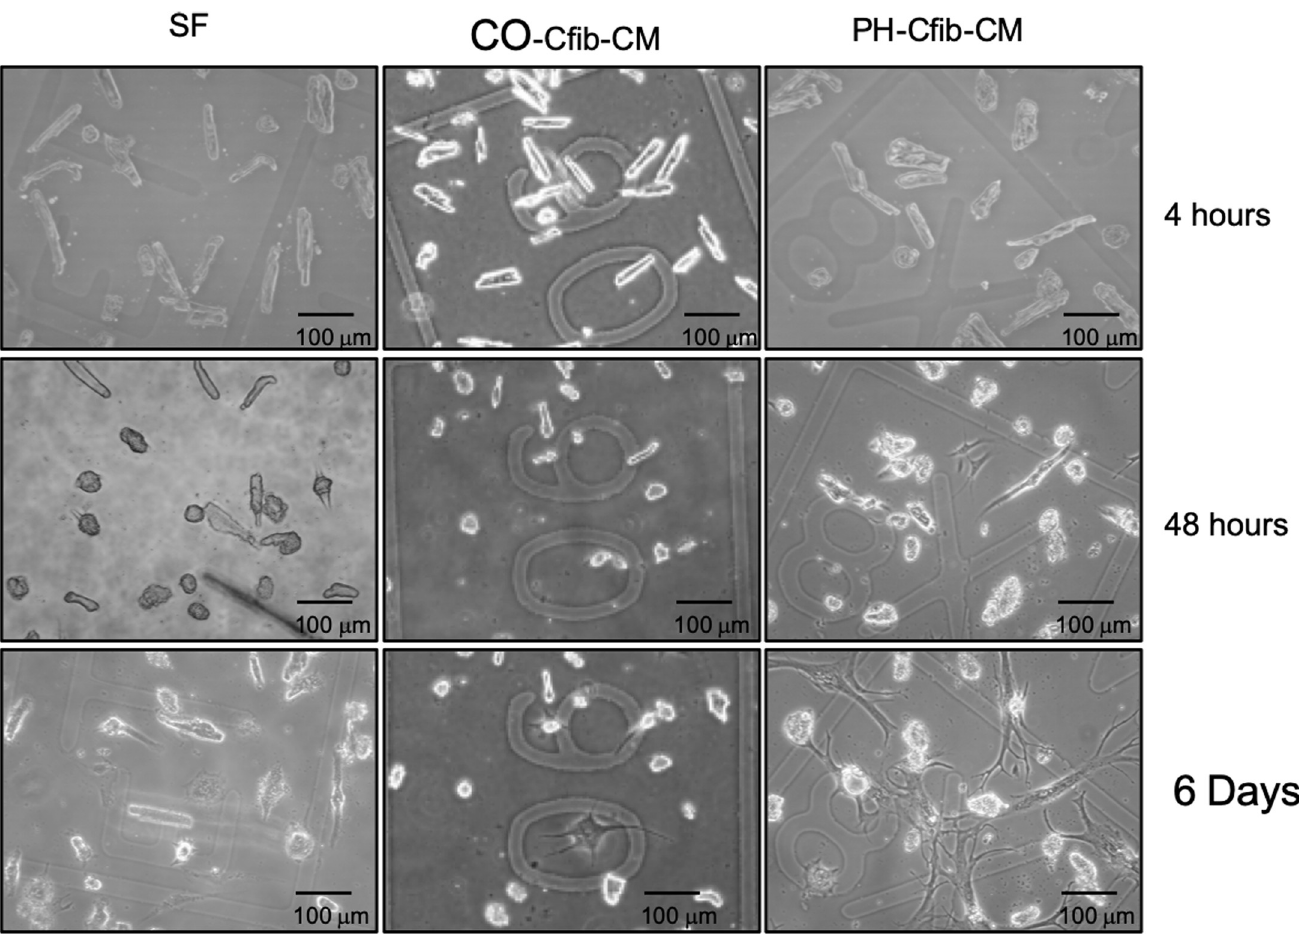
Fig 2. Cardiac fibroblast conditioned media (CM) from calves with pulmonary hypertension (PH) induced right ventricular dysfunction stimulates myocyte dedifferentiation. Adult rat ventricular myocytes (ARVM) were plated on etched coverslips to allow visual tracking of the same cell over time and incubated with serum-free (SF) media or CM derived from cardiac fibroblasts from calves exposed to control (CO) or PH conditions. By 48 hours myocytes in PH-Cfib-CM show signs of flattening, loss of striations, and branching of cellular processes. CM generated from control calf fibroblasts did not induce significant dedifferentiation.